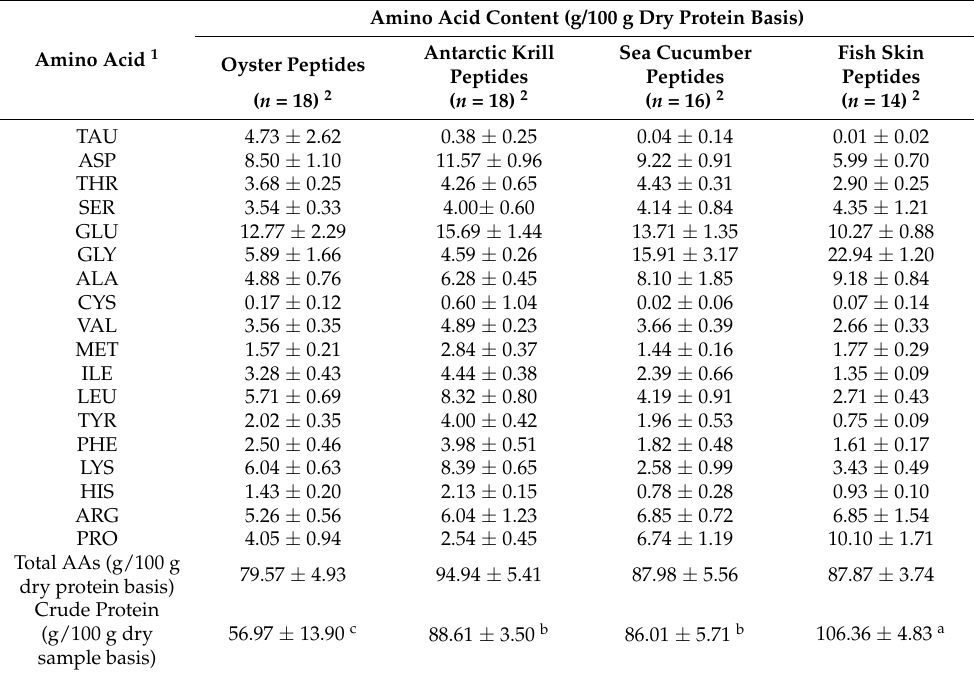
Table 2. Crude protein contents and hydrolyzed amino acid compositions of the four marine-derived peptide powder